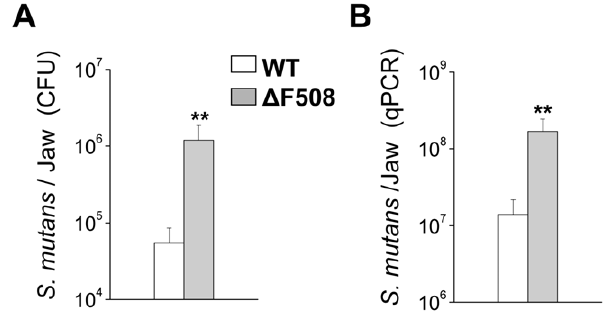
Figure 2. Number of viable S.mutans cells were dramatically increased in D F508 mutant mice. Bacterial counts in the lower jaws were evaluated by two independent techniques. Panel A. Numbers of colony forming units (CFU) were calculated by plating bacterial suspensions in MSB plates and counting using a grid plate system. Panel B. S. mutans in the mandibular jaws were also estimated using quantitative real-time PCR. Open and filled bars correspond to wildtype (WT, n=9) and mutant ( D F508, n=5) mice, respectively. Values are given as the mean 6 S.E.M. ** p , 0.02, t test.